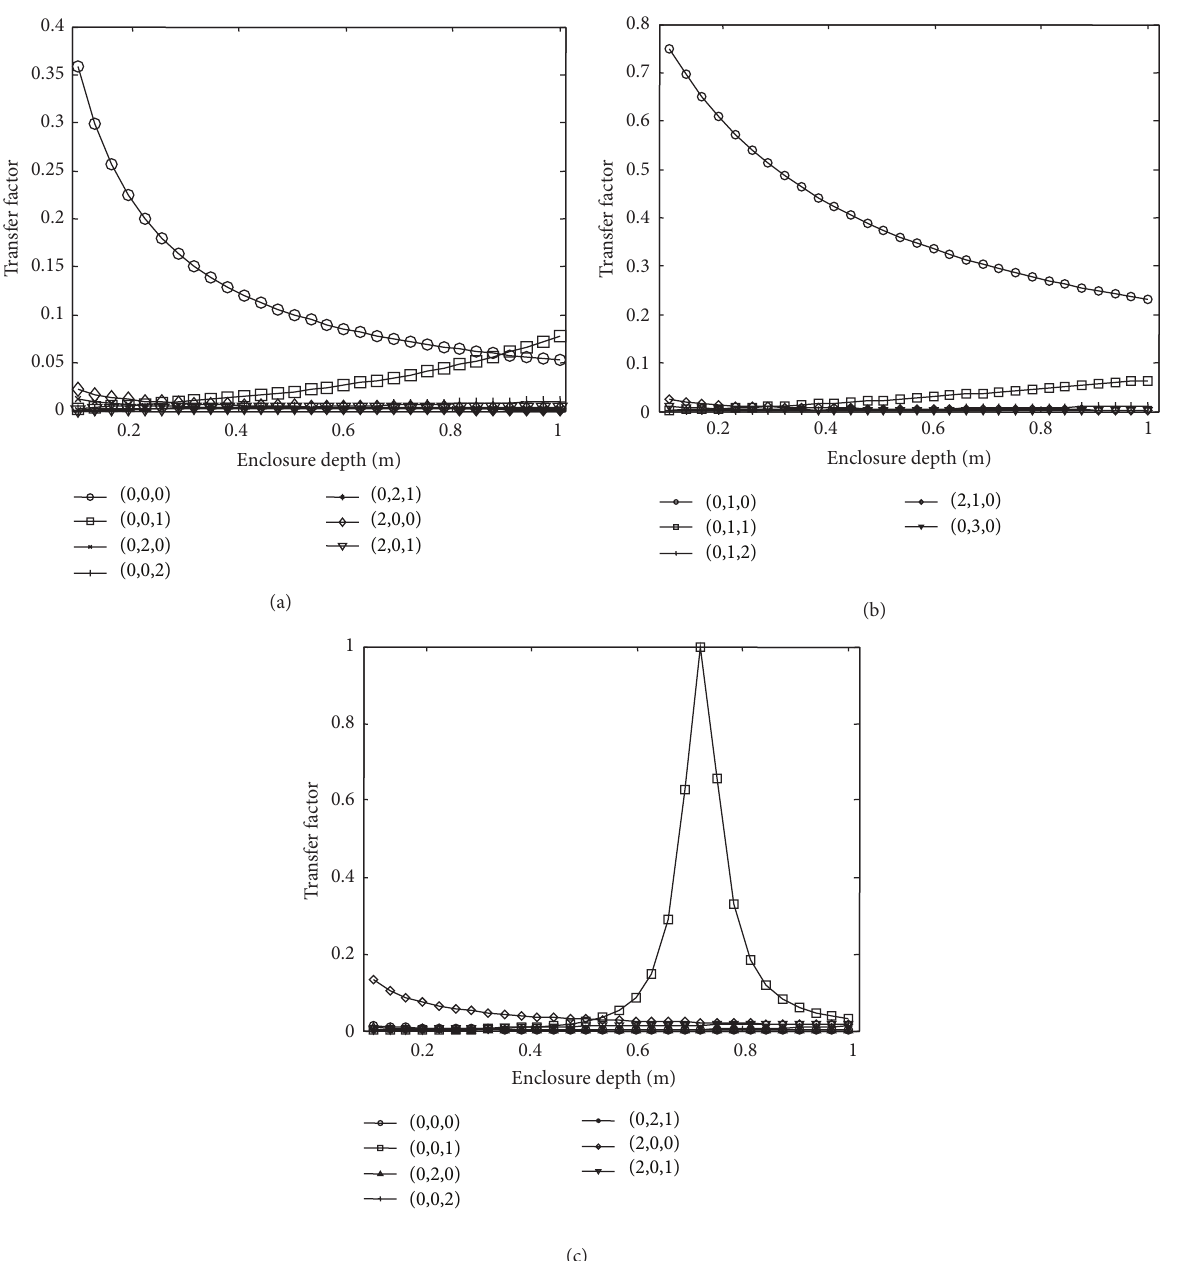
Figure 8: Transfer factors between enclosure modes and panel modes as a function of enclosure depth. (a) (1,1) panel mode; (b) (1,2) panel mode; (c) (3,1) panel mode; ℎ = 0.007 m, 𝑇 𝑎𝑁 = 15 s, 𝑇 𝑝𝑀 = 0.5 s.